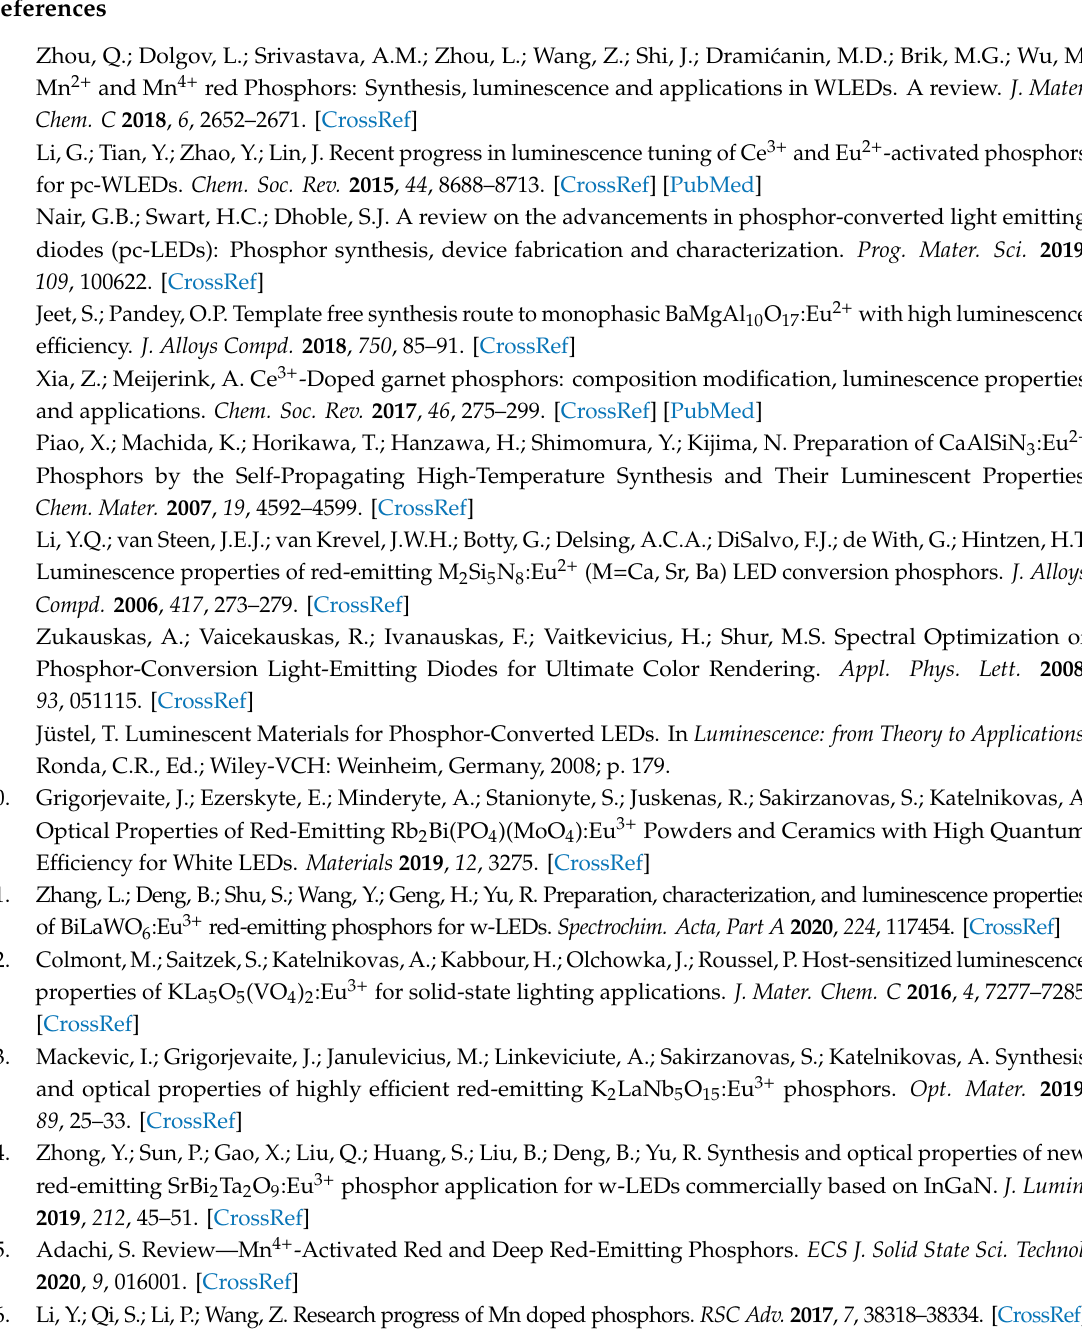
coordinates and luminous e ffi cacies (LE) of synthesized phosphors as a function of Eu 3 + concentration and excitation wavelength, Table S6: CIE 1931 colour coordinates and luminous e ffi cacies (LE) of Ba 2 Y 5 B 5 O 17 :50%Eu 3 + as a function of temperature ( λ ex = 394 nm), Table S7: CIE 1931 colour coordinates and luminous e ffi cacies (LE) of di ff erent thicknesses Ba 2 Y 5 B 5 O 17 :50%Eu 3 + ceramics mounted on 375, 400, and 455 nm